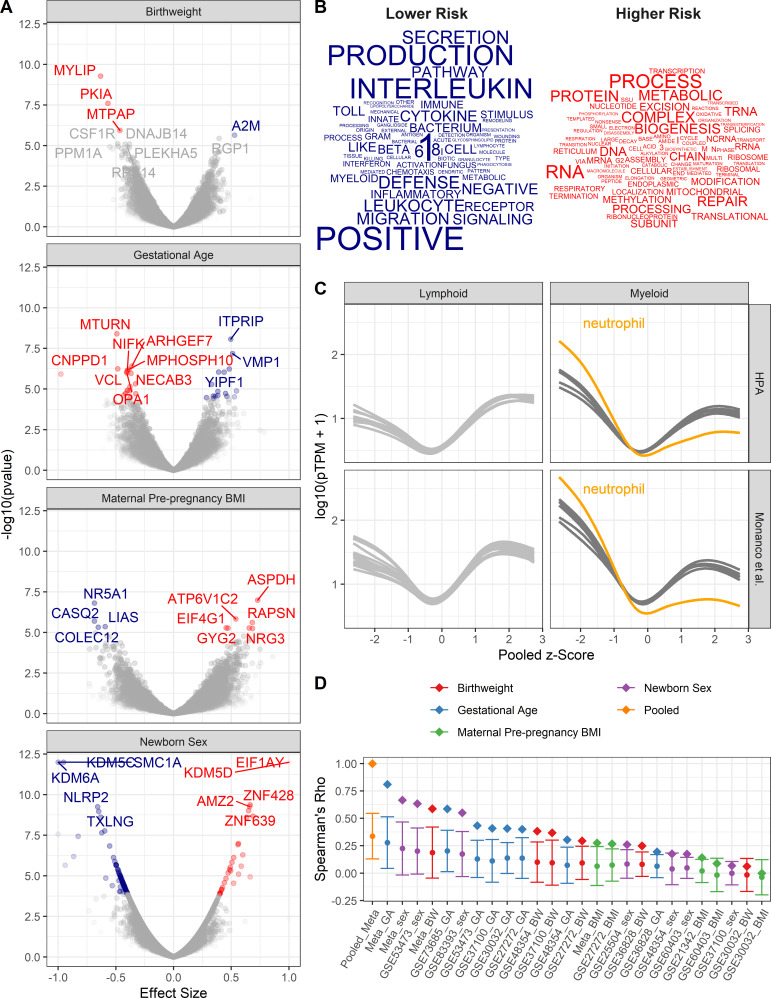
Pooled meta-analysis z-scores identify gene expression signatures related to asthma risk.Significant (FDR < 1%) genes and gene sets are colored by their association with either higher (red) or lower (blue) risk. (A) Volcano plots of gene expression for univariate analyses. Top 10 most significant genes labeled. (B) Word clouds of GO terms significantly enriched (FDR < 1%) using the pooled z-score as pre-ranked list for GSEA. (C) Protein coding transcripts per million reads (pTPM) in peripheral blood cells (Human Protein Atlas and Monaco et al (Uhlen et al., 2010; Monaco et al., 2019) relative to pooled z-score. Each line represents one cell type; neutrophils highlighted in orange. (D) Spearman’s correlation between pooled z-statistic and individual analyses (diamonds). Average Spearman’s correlations between individual analyses and combination of all other analyses (circle), SD indicated by error bars.